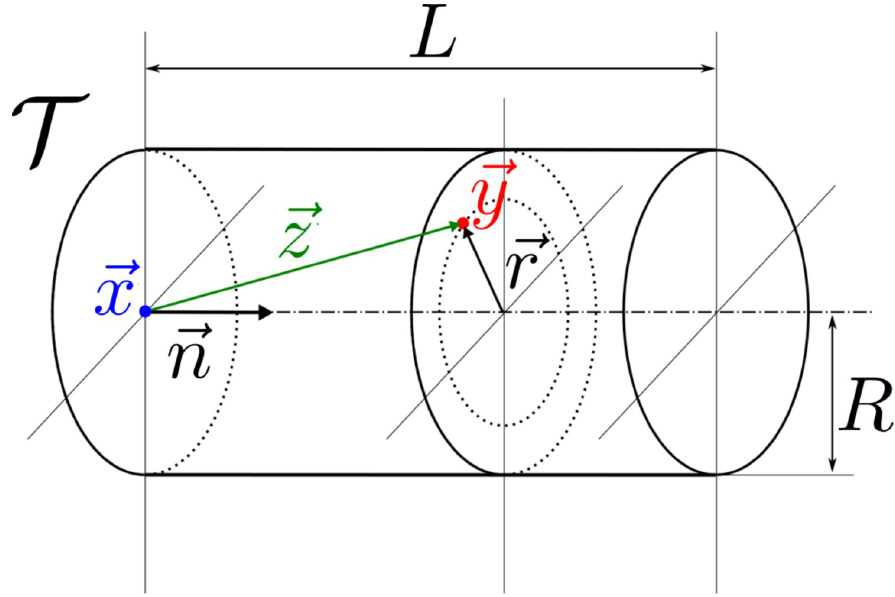
Fig 5. Generating vessel T ð x ; n ; L ; R Þ , see Eq (1).